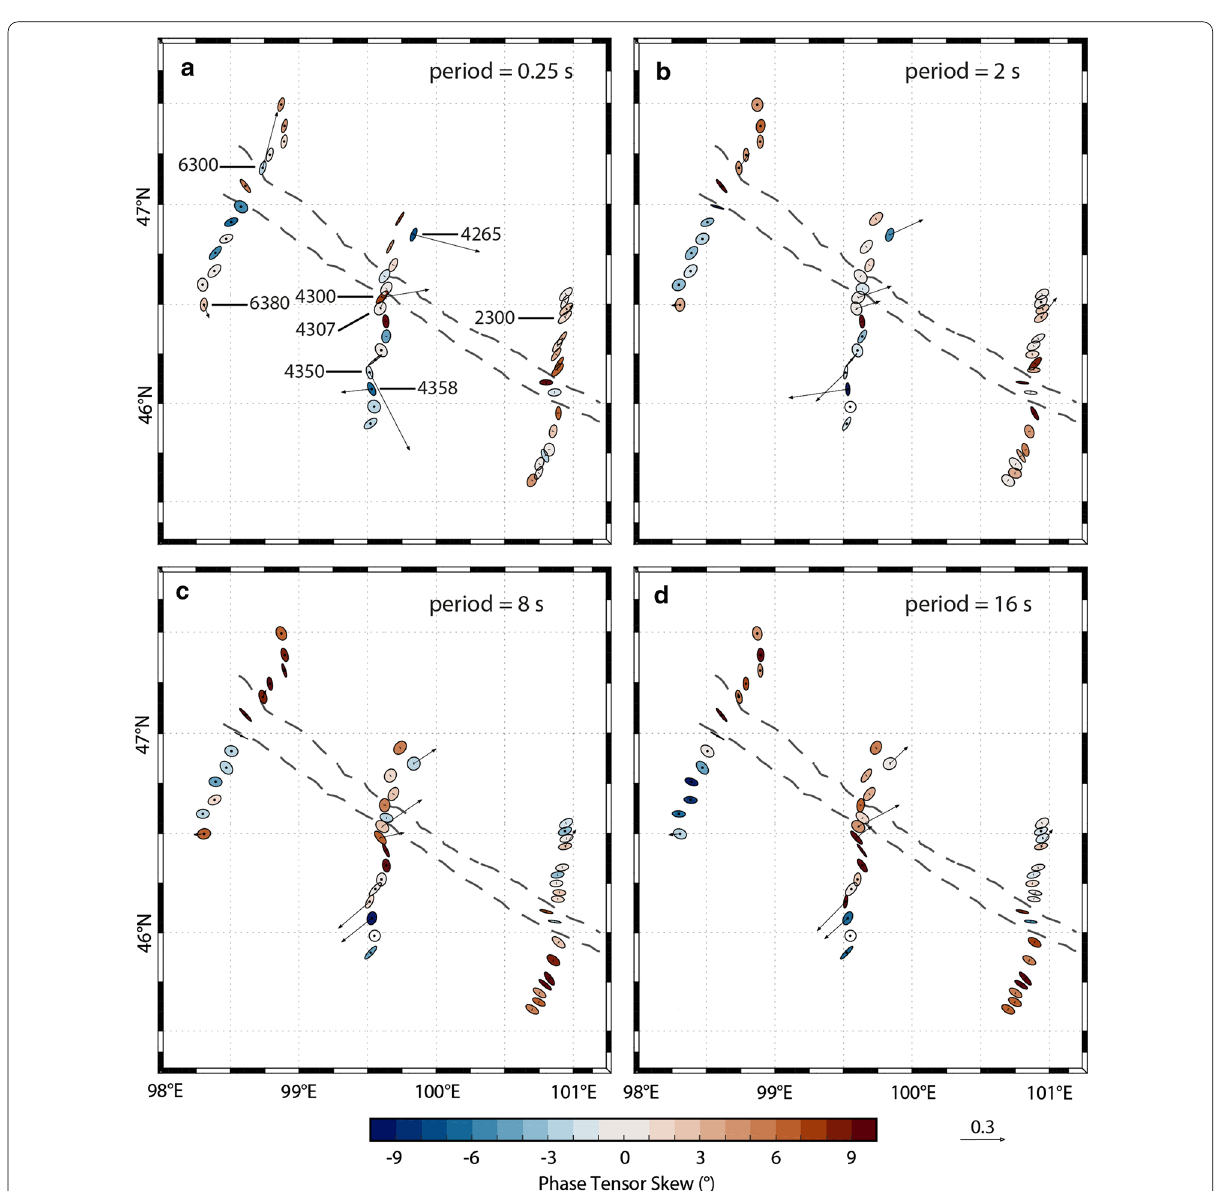
Fig. 3 Phase tensor ellipses computed from the data. They are shown in map view for selected periods of approximately a 0.25 s, b 2 s, c 8 s, and d 16 s. They have been normalized by their maximum axis values and are colored with their skew values. Elongated ellipses and large absolute skew values indicate possible 3-D effects. The periods correspond to depths of approximately 2 km, 7 km, 14 km, and 21 km, respectively, from simple skin depth estimations. Induction vectors (arrows) are computed from the tipper data (site names are marked); they point away from conductors (i.e., Wiese convention). A scale arrow of magnitude 0.3 is shown. The approximate location of the Bayankhongor Ophiolite Belt is marked (dashed lines, as in Fig. 1). This feature appears to influence the phase tensors